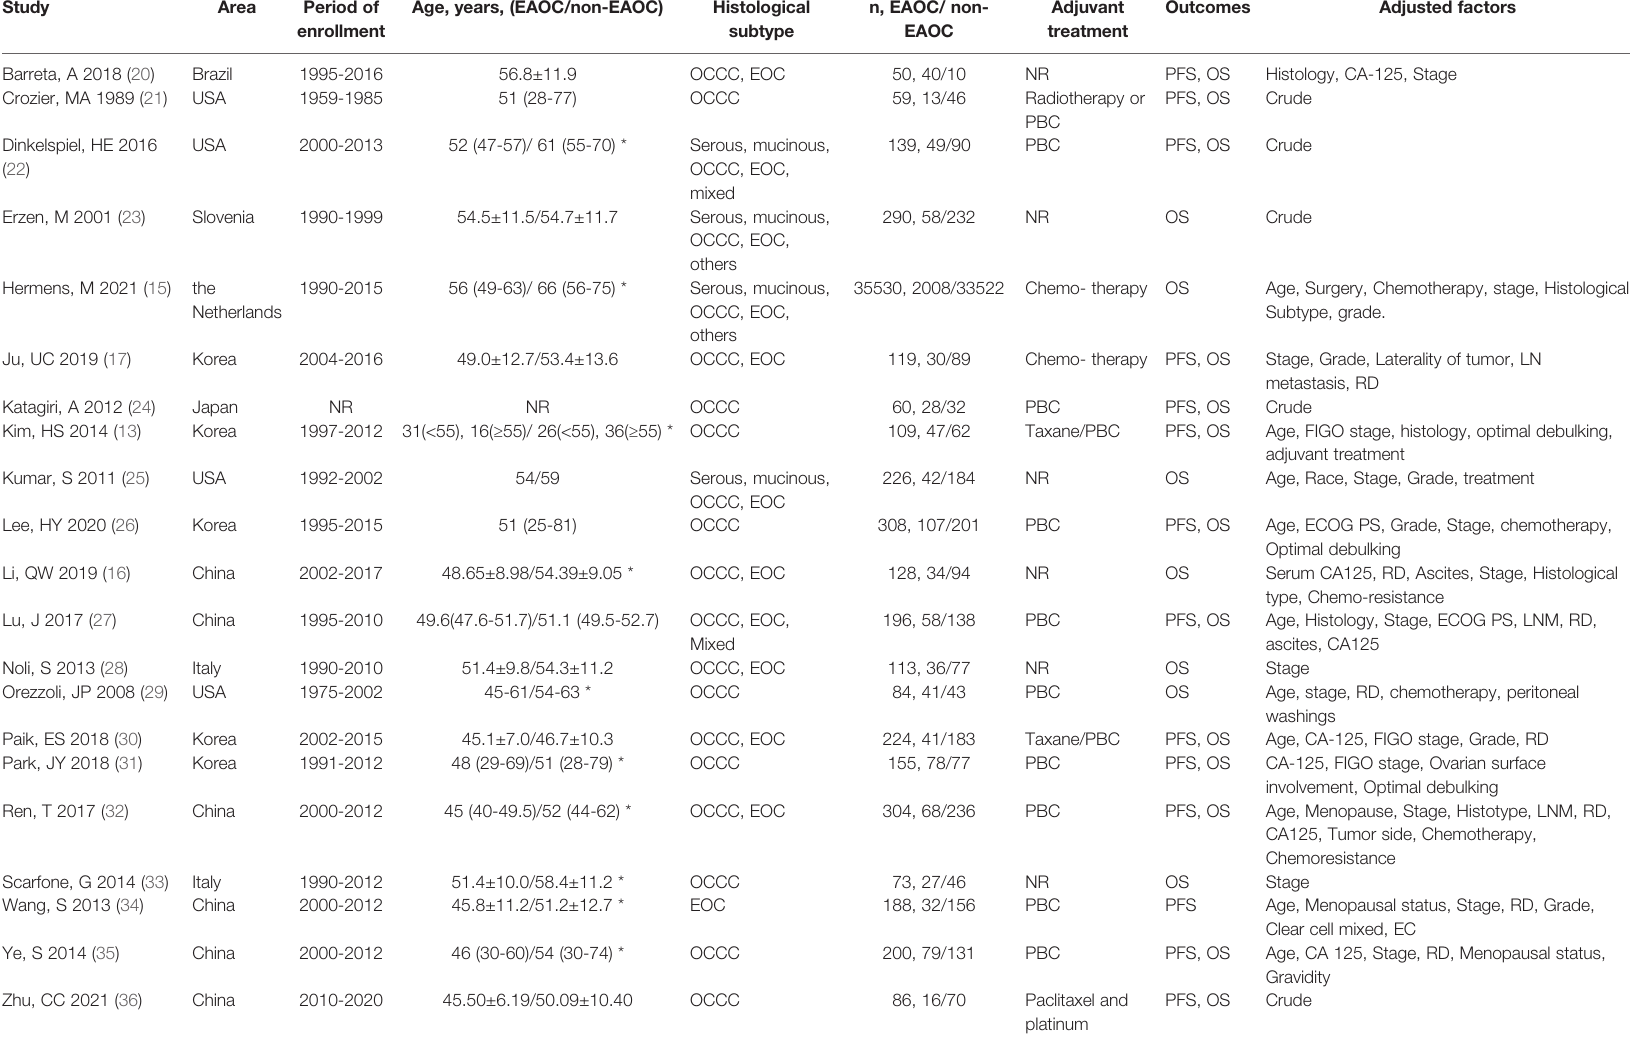
TABLE 1 | Characteristics of the included